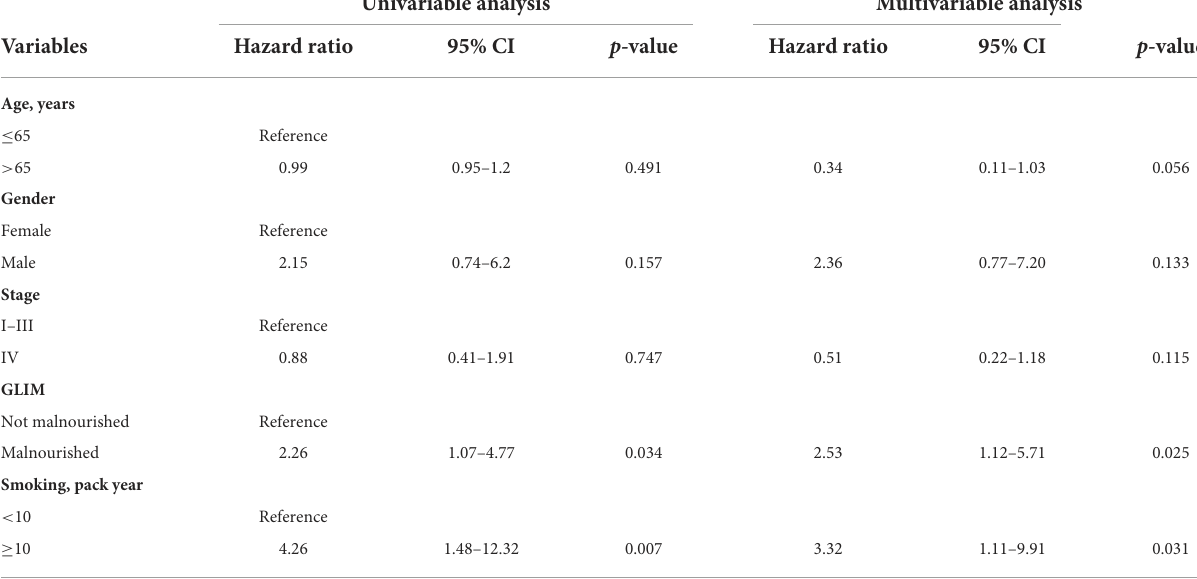
TABLE 4 Univariable and multivariable regression analysis of overall survival in 65 HNC